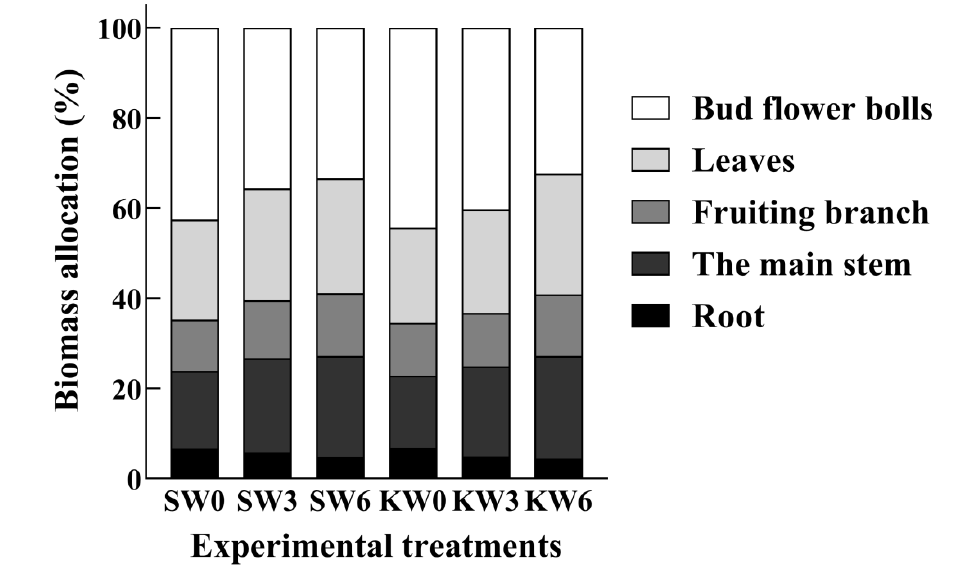
Figure 4. Effect of potassium application on biomass allocation in cotton under soil waterlogging stress. The experiment treatments were SW0 (no potassium application and no soil waterlogging), SW3 (no potassium application and 3 d soil waterlogging), SW6 (no potassium application and 6 d soil waterlogging), KW0 (potassium application and no soil waterlogging), KW3 (potassium application and 3 d soil waterlogging) and KW6 (potassium application and 6 d soil waterlogging).